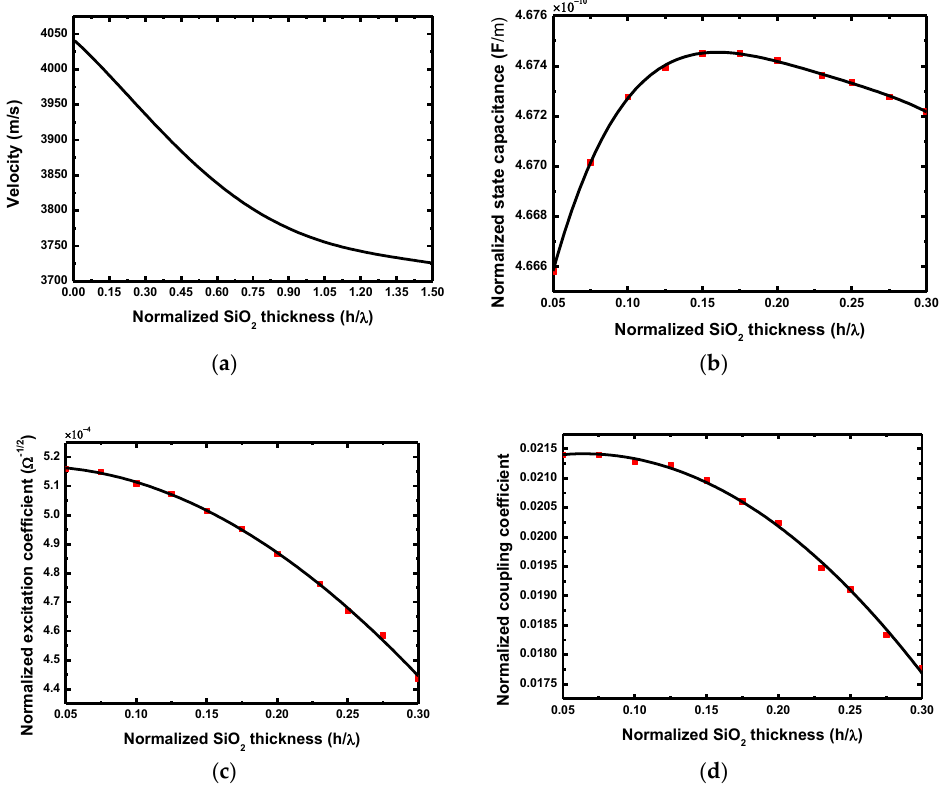
Figure 4. The calculated COM parameters varying with SiO 2 thickness: ( a ) velocity; ( b ) static capacitance; ( c ) excitation coefficient and ( d ) coupling coefficient.